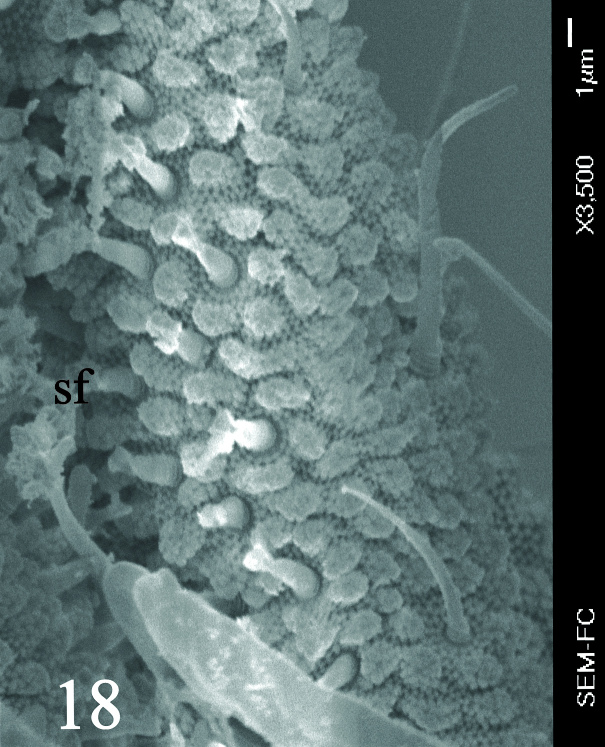
Ant. IV ventral file.